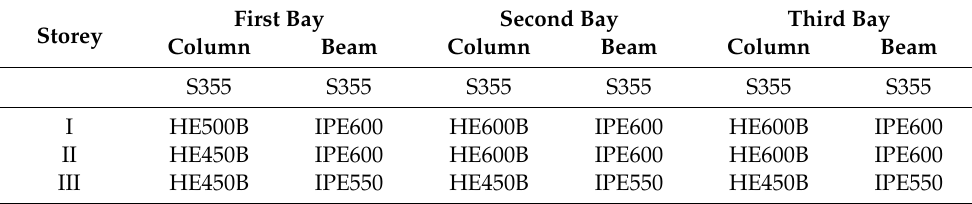
Table 3. Structural members for 3-Story moment resisting frame (MRF).